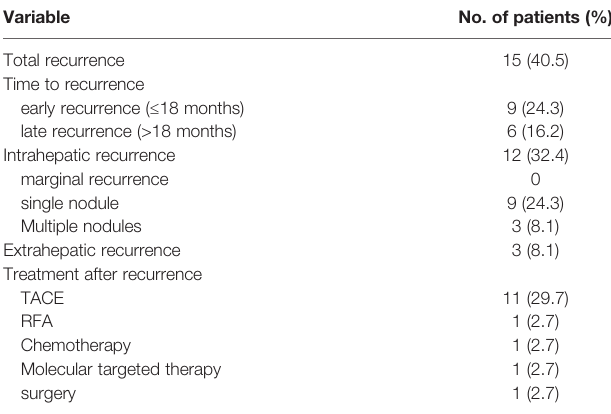
TABLE 3 | Pattern of